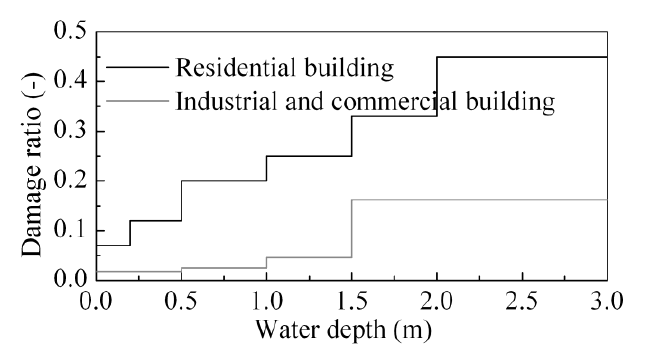
Figure 3. Depth-damage curves of residential, industrial and commercial